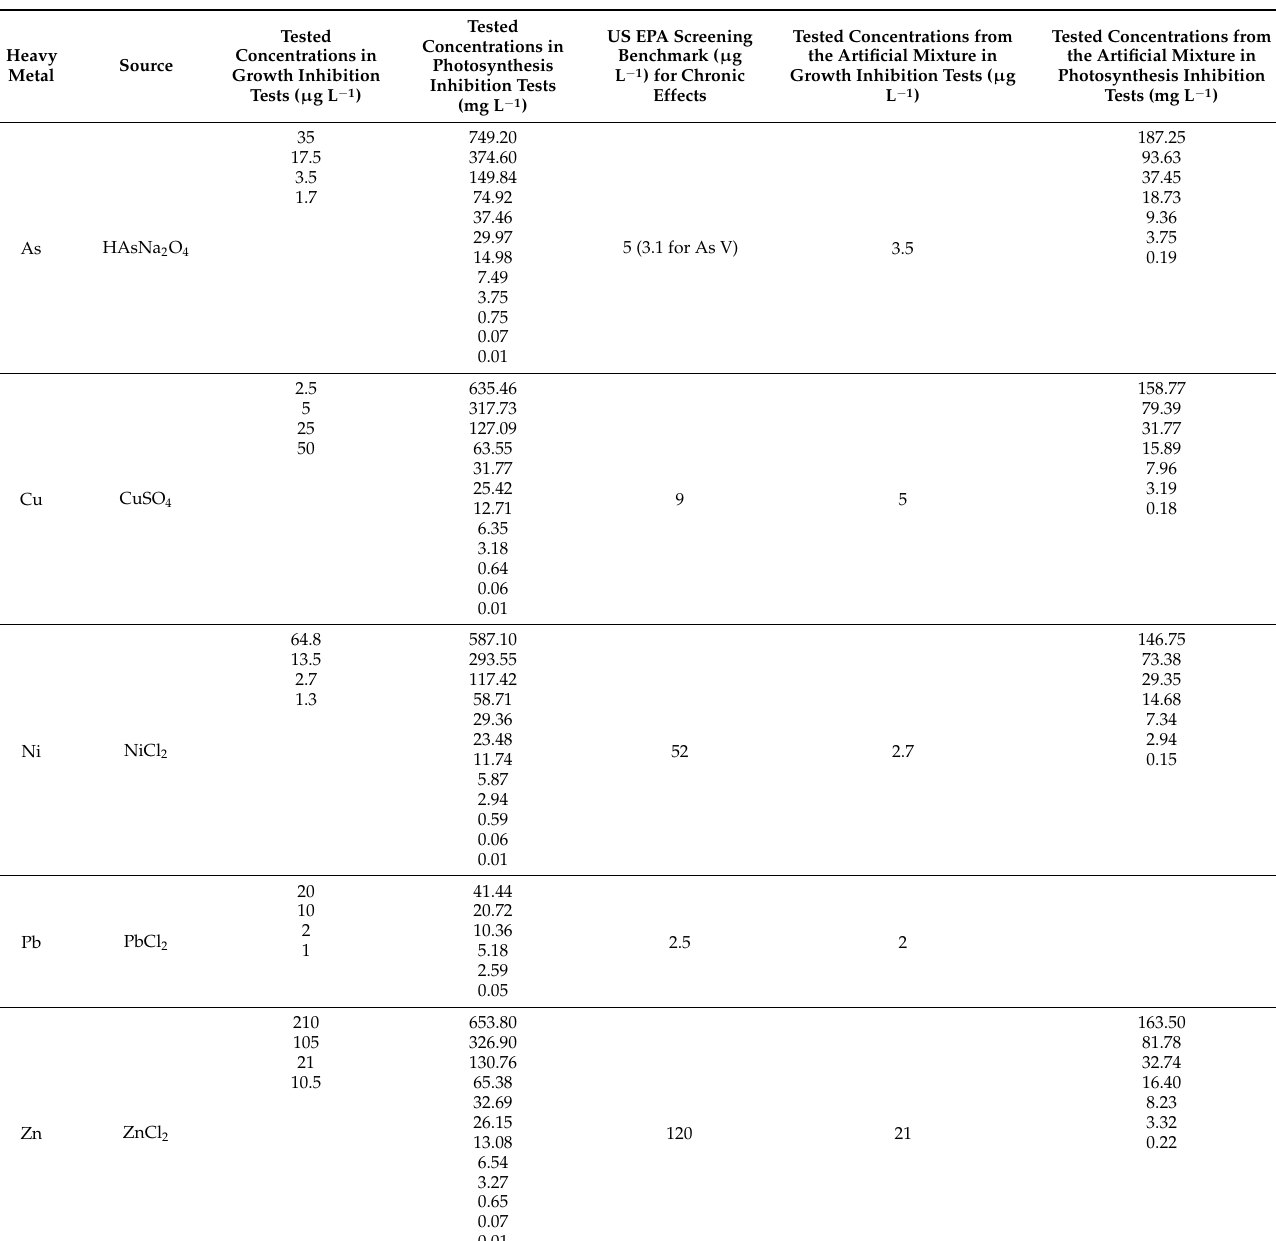
Table 1. Tested single heavy metal dilutions: United States Environmental Protection Agency (US EPA) benchmarks in water hardness of 100 mg L − 1 [41], and heavy metal levels in the artificial mixture in growth (selection based on data from [39,40]) and in photosynthesis inhibition